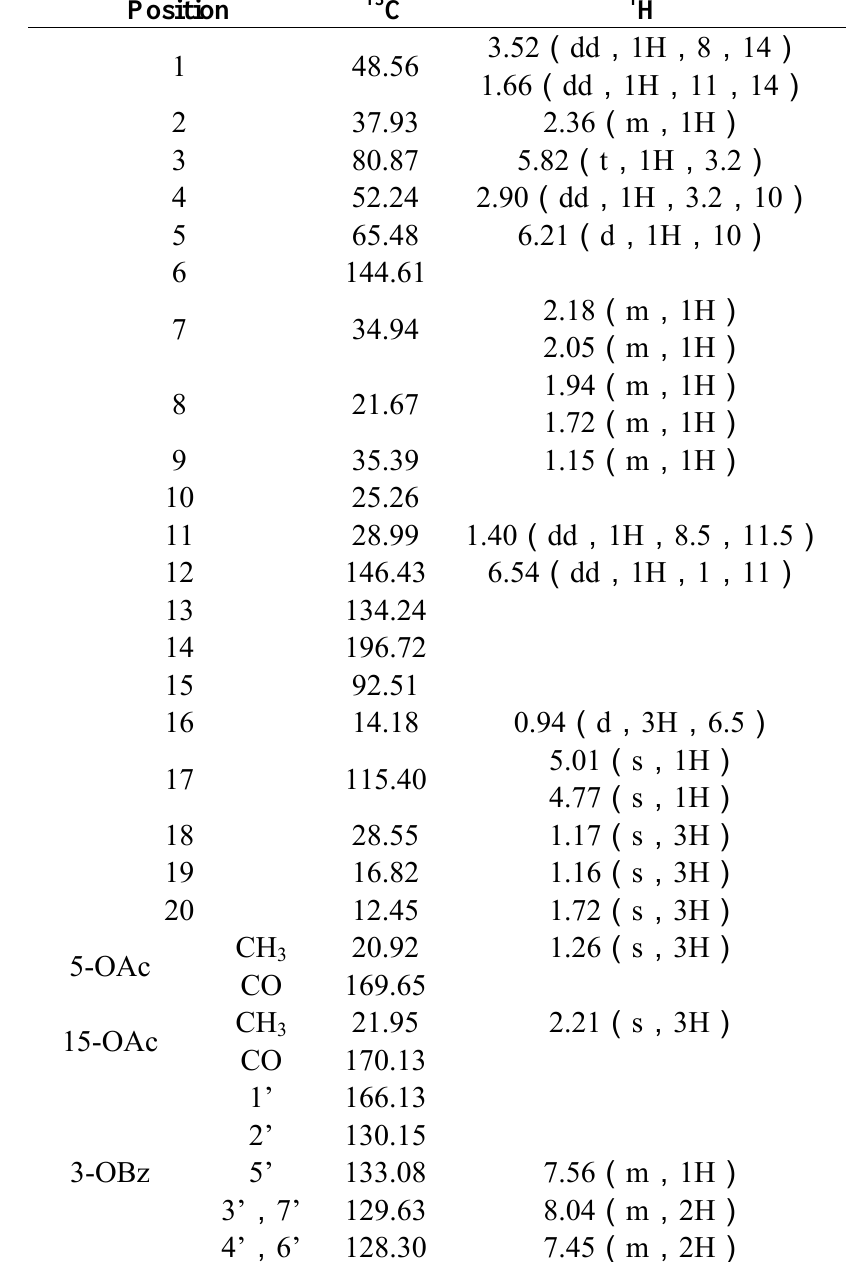
Table 1. 1 H and 13 C NMR spectral data (400 and 100 MHz, δ in ppm, multiplicities, J in